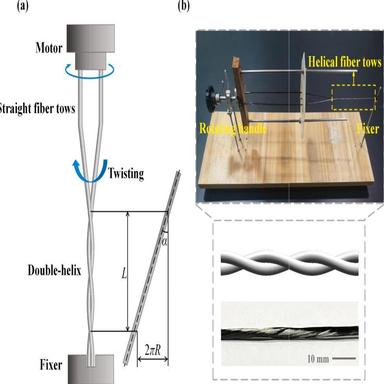
(a) Twisting principle; (b) Manual processing device with helical fiber tows.